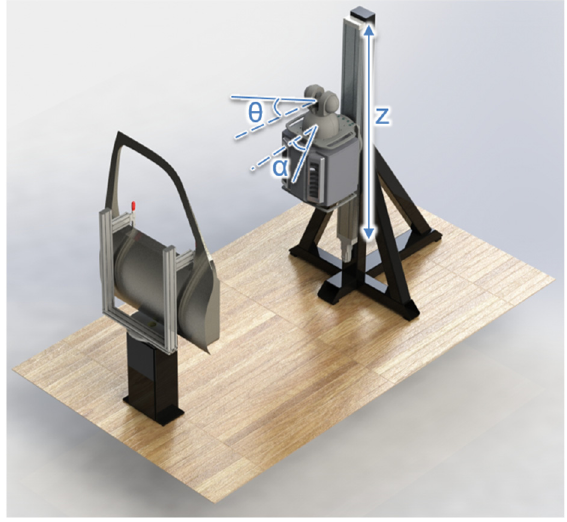
Figure 26. Early virtual illustration example of the 3D scene in IPS LR application using a car door as virtual test object.